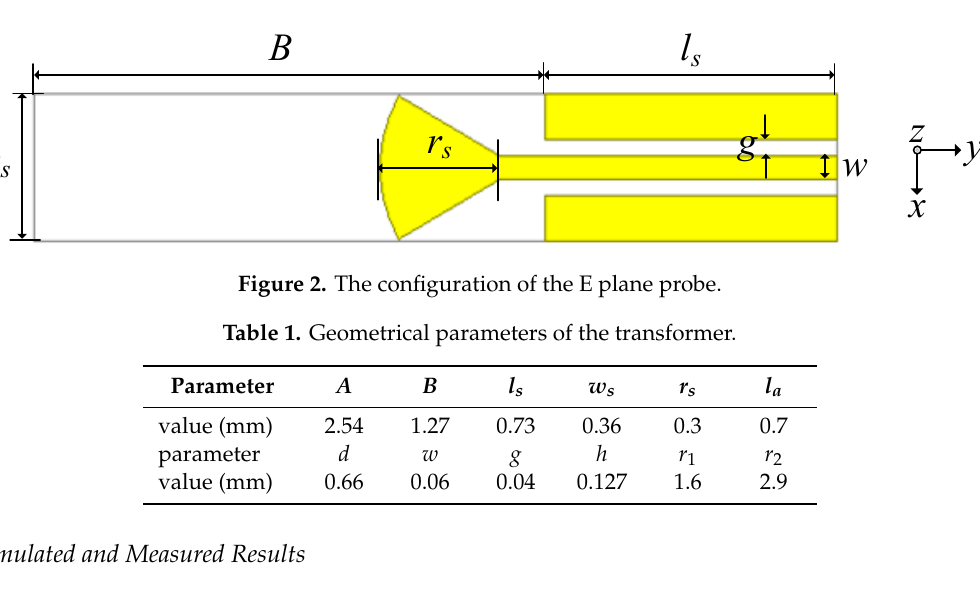
Figure 4. Simulated and measured S-parameters of the transition. 3. Package and Measurement of RTD The packaged RTD configuration with WR10 waveguide output and an SMA connector is shown in Figure 5. The packaged RTD consisted of a DC bias microstrip line (MSL), an RTD chip, an E plane probe transformer, and a metallic cavity with WR 10 waveguide output. The DC bias MSL that was connected to an SMA connector was used to bias the RTD. The MSL was designed on the Rogers 6010 substrate with a relative permittivity of 10.2 and a thickness of 127 μ m. The width of the MSL was 0.1 mm to match with the 50 Ω SMA connector. The RTD chip was the same as in the one used in the literature [14], and the indium phosphide (InP) substrate height of the RTD was 600 μ m. The E plane probe transformer was used to radiate the RF signal of the RTD to the WR 10 waveguide. By using gold wire bonding, the signal and ground traces of the RTD were connected to the E plane probe transformer and the DC MSL was bonded to the DC trace of the RTD. A metallic package cavity with a WR-10 standard waveguide output was fabricated. We etched three slots in the cavity and used a conductive silver glue to fix the transformer, the RTD chip, and the DC bias MSL inside the cavity. The photograph and micrograph of the fabricated packaged RTD is shown in Figure 6.